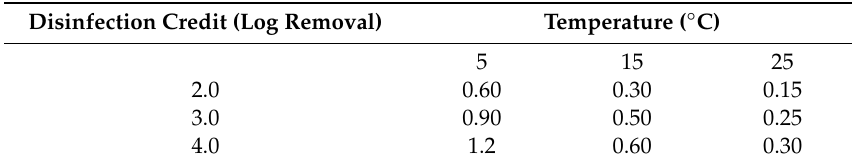
Table 6. Disinfection credits and CT values in mg-min / L for inactivation of viruses by ozone, and noted by the USEPA, 1991. [178].